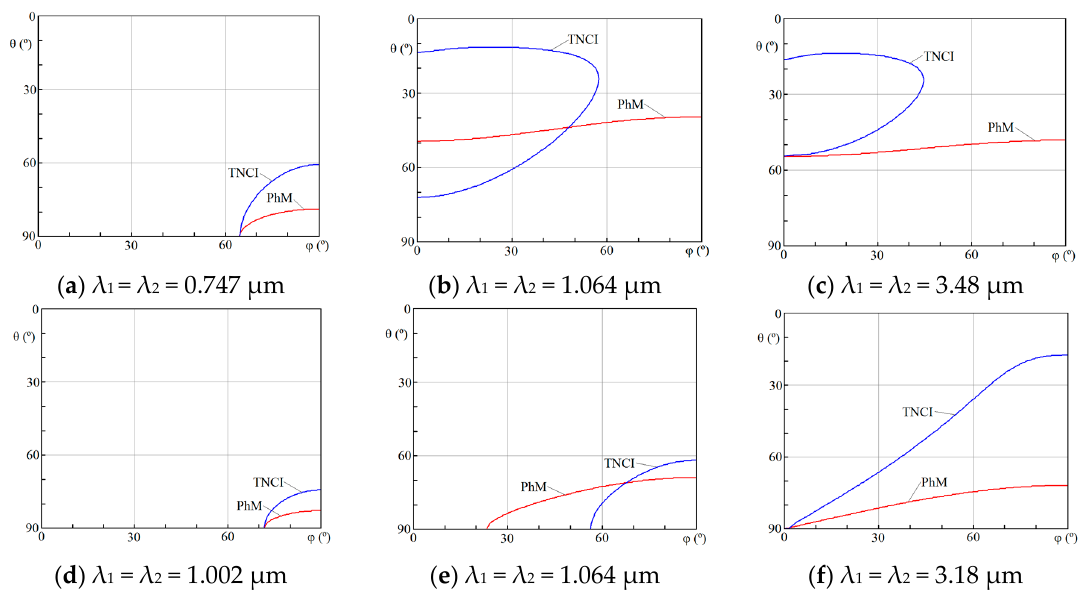
Figure 11. Angular dependencies of PhM and TNCI directions for SHG in KTP crystal at different wavelengths for ( a – c ): ssf , and ( d – f ): sff types of interactions. wavelengths for ( a – c ): ssf , and ( d – f ): sff types of